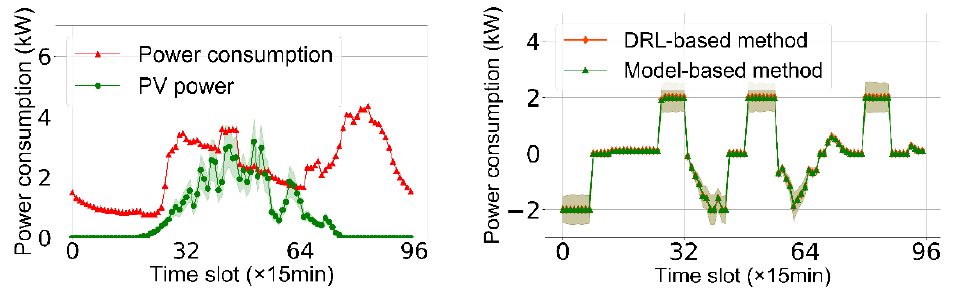
Figure 16. Comparison of consumption power between MAPPDG and the model-based method in low light.